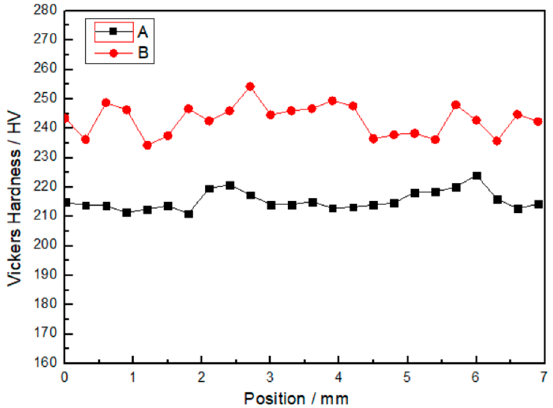
Figure 12. The surface hardness profiles of alloy coatings A and B.